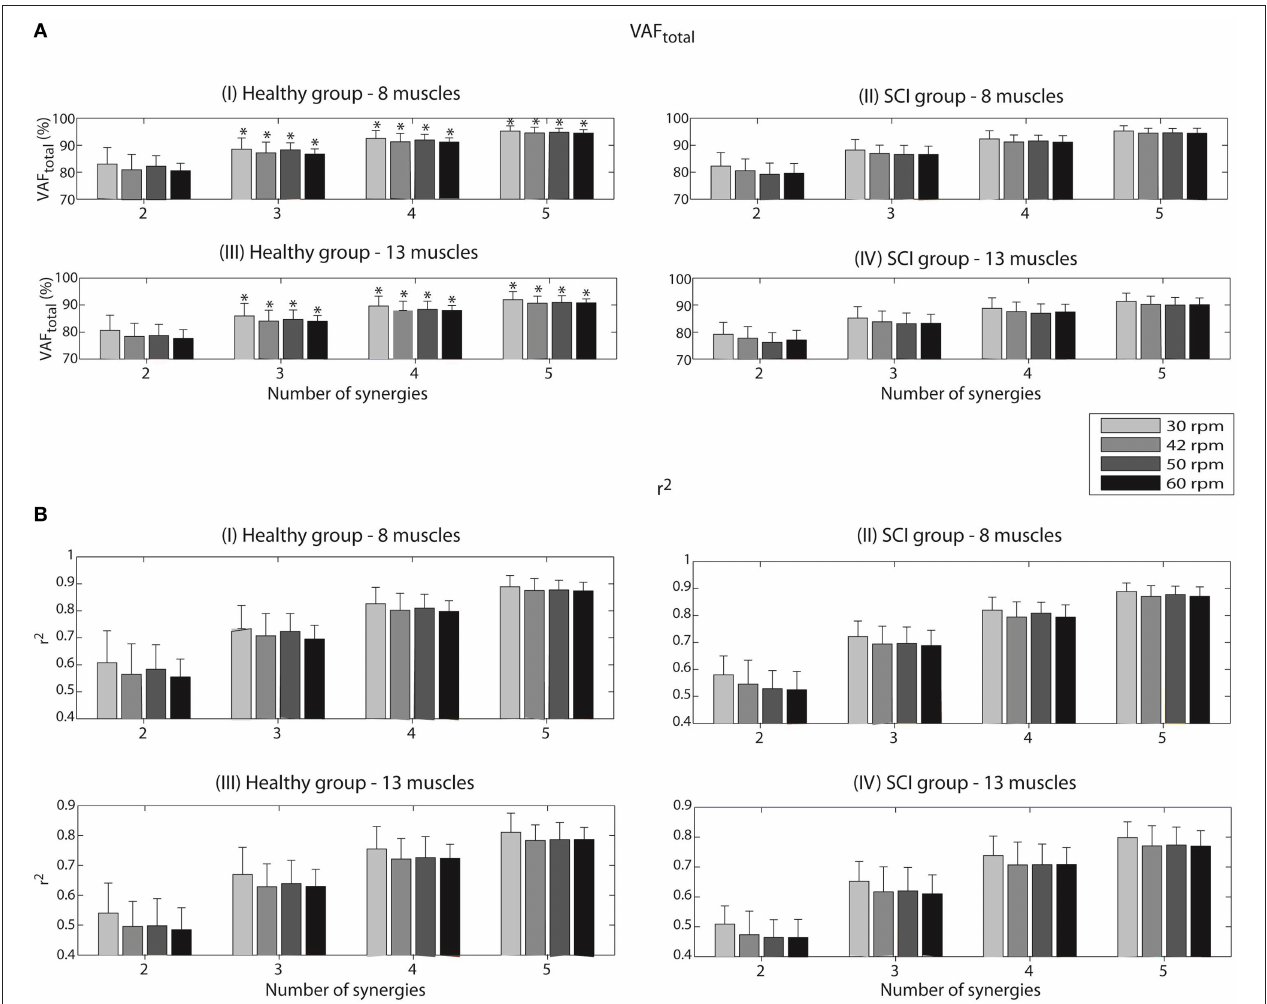
FIGURE 2 | Variability accounted for (VAF total ) (A) and coefficient of determination ( r 2 ) (B) according to the number of synergies, for each of the four speeds (30, 42, 50, and 60rpm). Values are given in means ± SD. These reconstruction goodness indexes were calculated after running the NNMF algorithm to reconstruct a set of 8 EMG envelopes for the healthy group (I) and the iSCI group (II), as well as a set of 13 EMG envelopes (III and IV for the healthy group and iSCI group, respectively). A VAF total value of 100% and a r 2 value of 1 mean perfect reconstruction of the EMG set. * Number of synergies sufficient to describe VAF total values ≥ 85% for at least half of the healthy